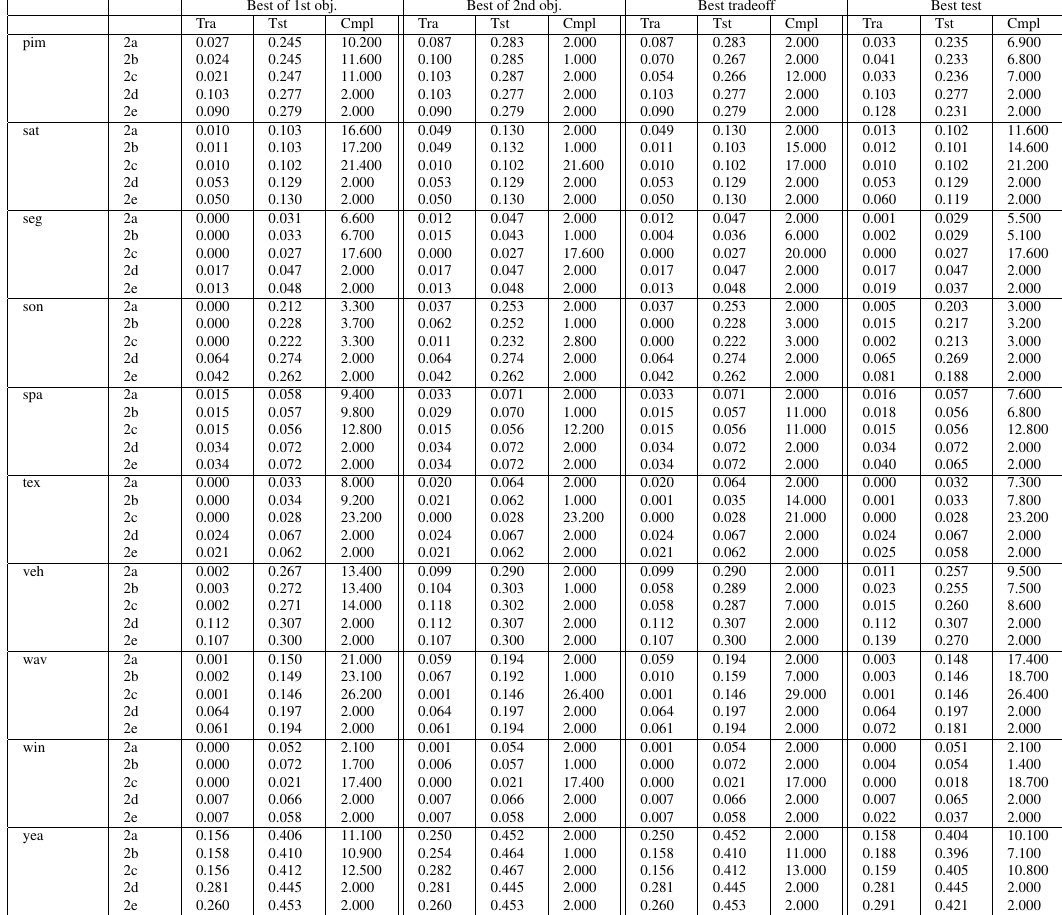
Table 10: Statistics of four single solutions selected from the Pareto fronts.(cont.) Bestof1stobj. Bestof2ndobj.